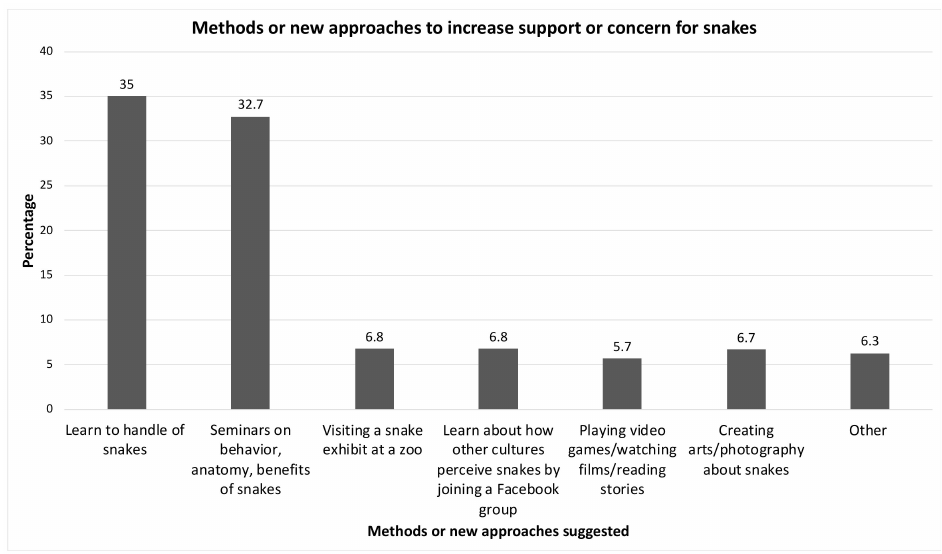
Figure 4. Methods and new approaches that would increase respect for